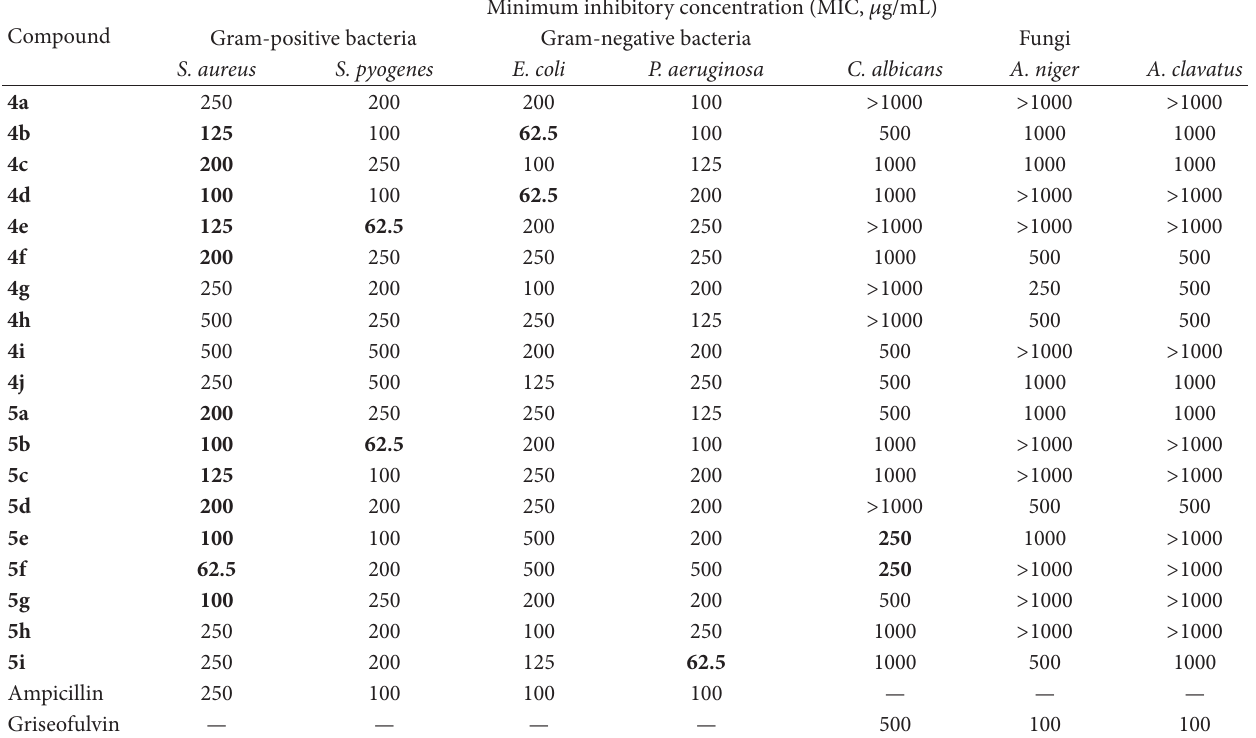
T 3: Antibacterial and antifungal data of newly synthesized pyrazole-pyrazolone ( 4a–j ) and chromone-pyrazolone ( 5a–i ) indicated by MIC values ( 𝜇𝜇